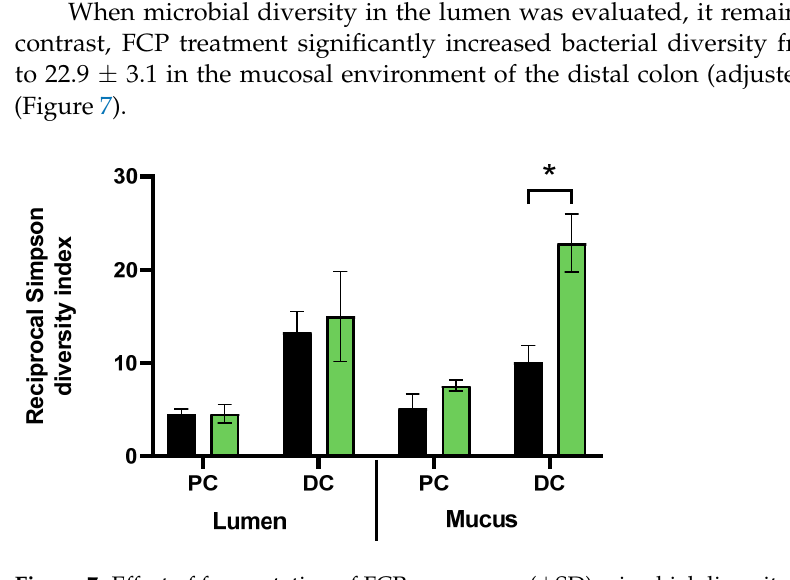
Figure 7. Effect of fermentation of FCP on average (±SD) microbial diversity (reciprocal Simpson diversity index) in the simulated proximal colon and distal colon of the triple-M-SHIME, at the end of the treatment period (TR: Day 35) and the end of the control period (C: Day 14) ( n = 1 for 3 donors). Statistical differences due to treatment were indicated by * (0.01 < adjusted p -value < 0.05). When data was presented at phylum level (Figure 8), FCP treatment resulted in a consistent increase of Bacteroidetes levels in the proximal colon (+17.5 ± 9.3%) at the ex- pense of Proteobacteria ( − 10.2 ± 1.5%). When focusing on intrinsic differences between the simulated lumen and mucus, it was noted that the simulated mucus was enriched with Actinobacteria and Synergistetes/Firmicutes in the proximal and distal colon, respectively. Figure 8. Effect of FCP on microbial composition (phylum level) in the lumen ( A ) and mucus ( B ) (as estimated via 16S rRNA gene profiling (%)) of the simulated proximal and distal colon of the triple- M-SHIME at the end of the control (C: Day 14) and treatment period (TR: Day 35) ( n = 1). Tables 2 and S1 focus on the changes induced by FCP at family level of the lumen and simulated mucus, respectively. Positive values in the tables indicate that the abun- dance of a bacteria family was stimulated by FCP, while negative values suggest the